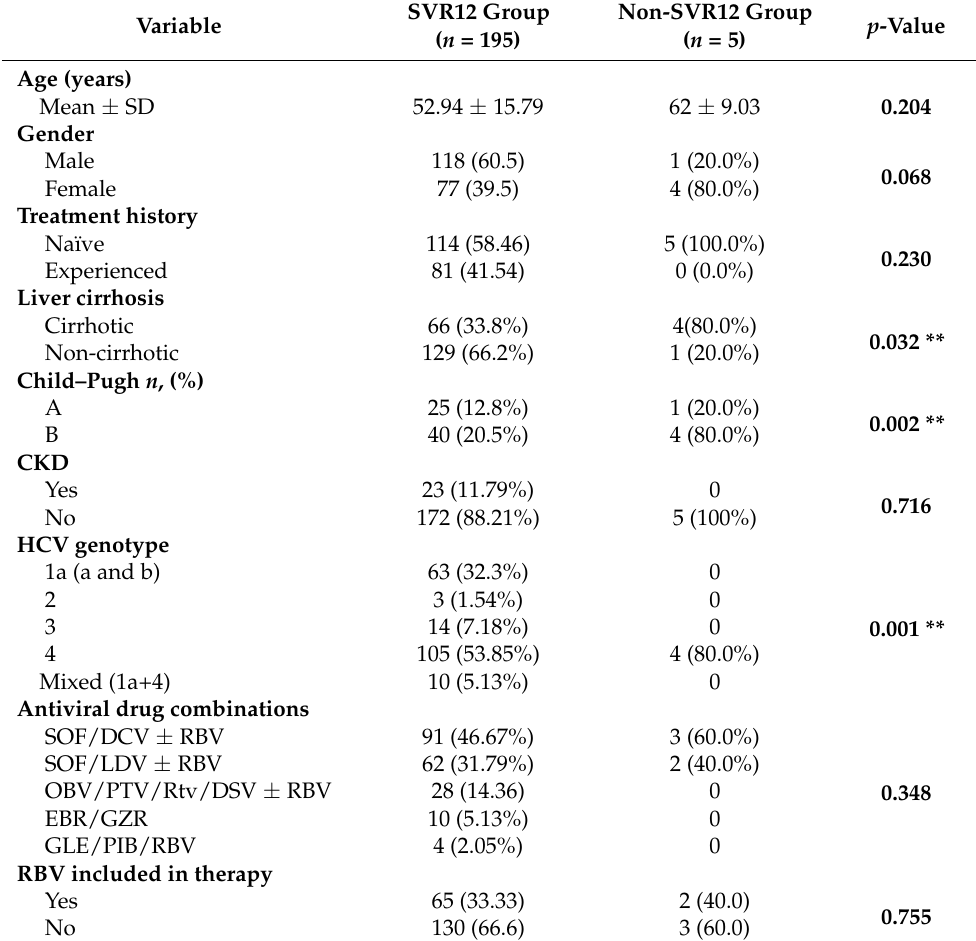
Table 3. Baseline characteristics of the study patients and the prescribed antiviral drugs according to the SVR12. Variable